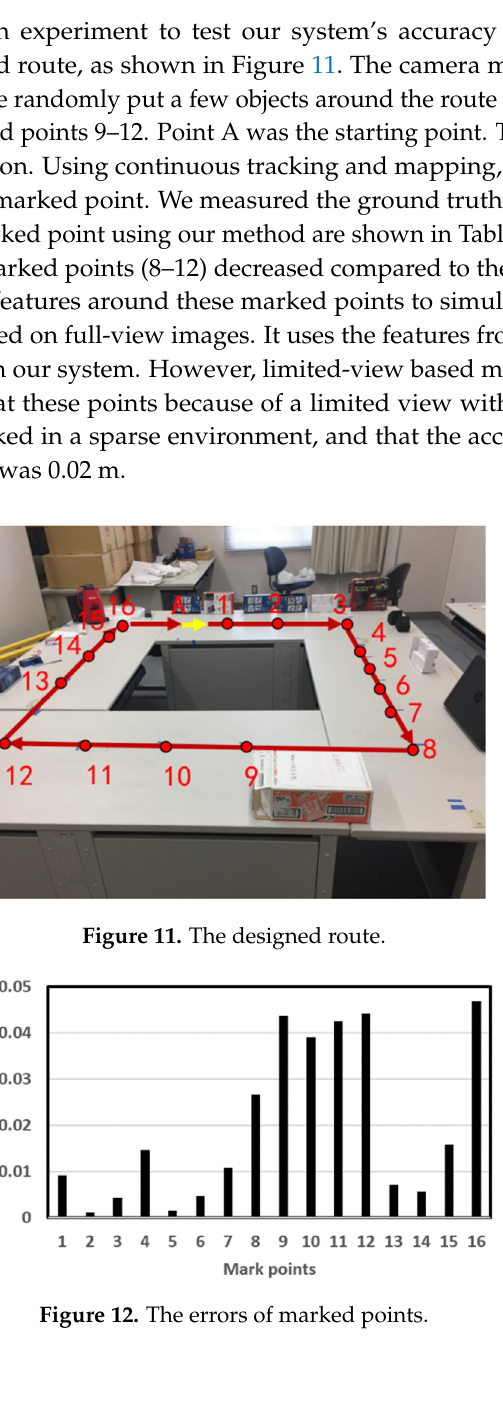
Figure 10. The map and the trajectory for Figure 9.